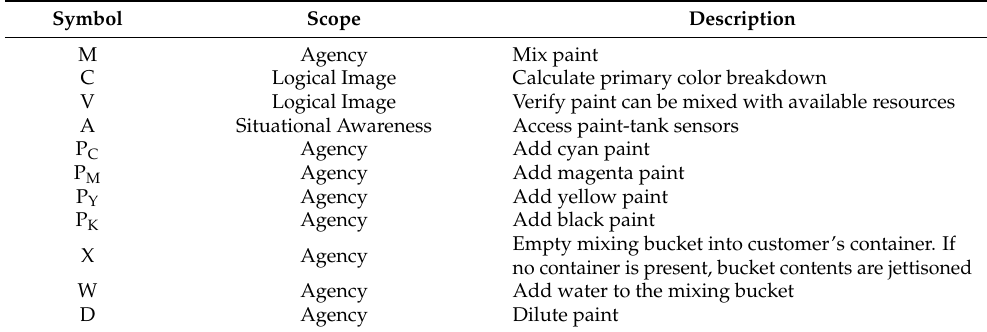
Table 2. Component tasks for the paint-mixing robot example.